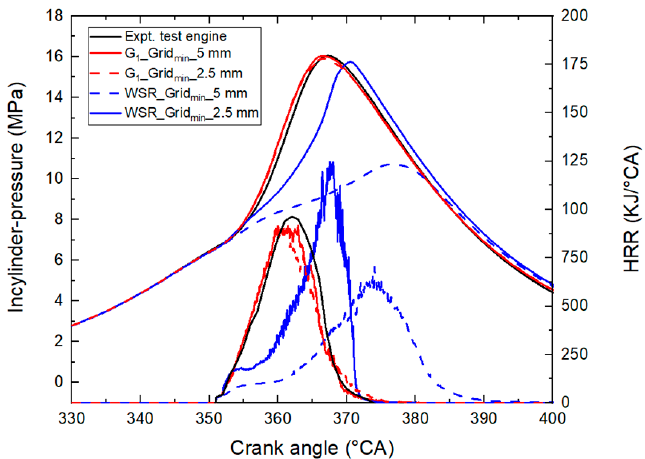
Figure 4. Experimental and predicted in-cylinder pressure and HRR of cases setup in Table 5.